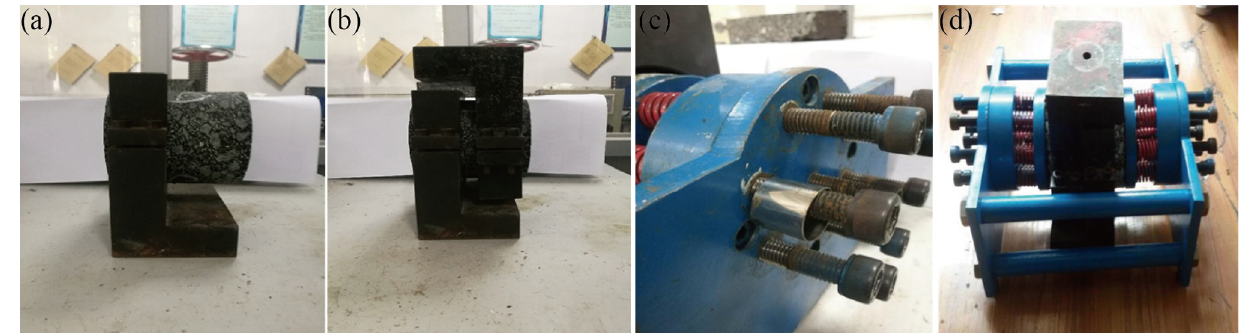
Figure 8. The process of test device installation: ( a ) mounting fixture; ( b ) installing the head contact clamp; ( c ) prefabricated stainless steel sleeve controls the spring compression; ( d ) image showing the completed fixture installation.